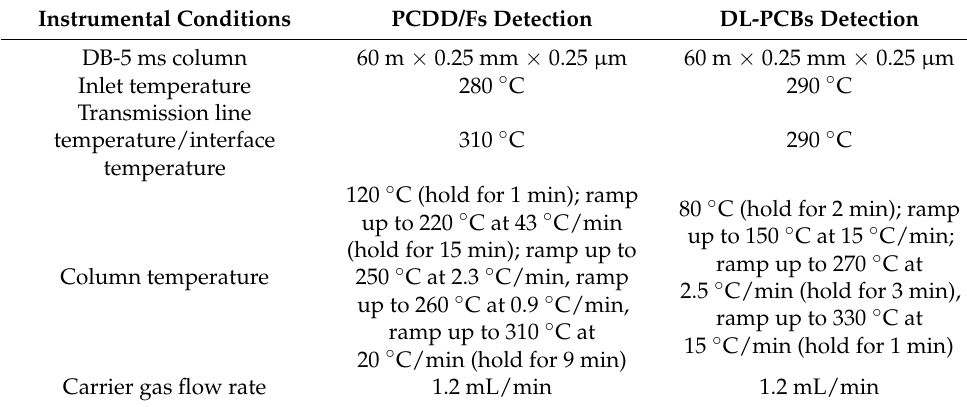
Table 2. Chromatographic condition